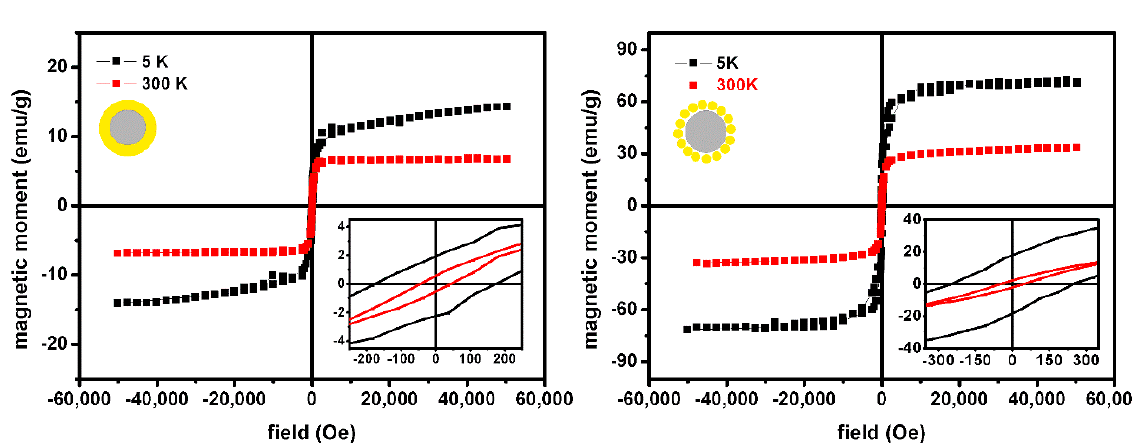
Figure 8. Magnetization hysteresis loops of MnFe 2 O 4 /Au core/shell nanoparticles (left) and MnFe 2 O 4 NPs decorated with Au (right) at 5 K and 300 K. Insets: Enlargement of the loops in the low field region. Table 4. Coercive field ( H c ), remnant magnetization ( M r ), saturation magnetization ( M s ), and magnetic squareness ratio ( M r / M s ) of MnFe 2 O 4 /Au core/shell nanoparticles and MnFe 2 O 4 NPs decorated with Au, at 5 K and 300 K. The magnetic properties of MnFe 2 O 4 nanoparticles are also shown for comparison